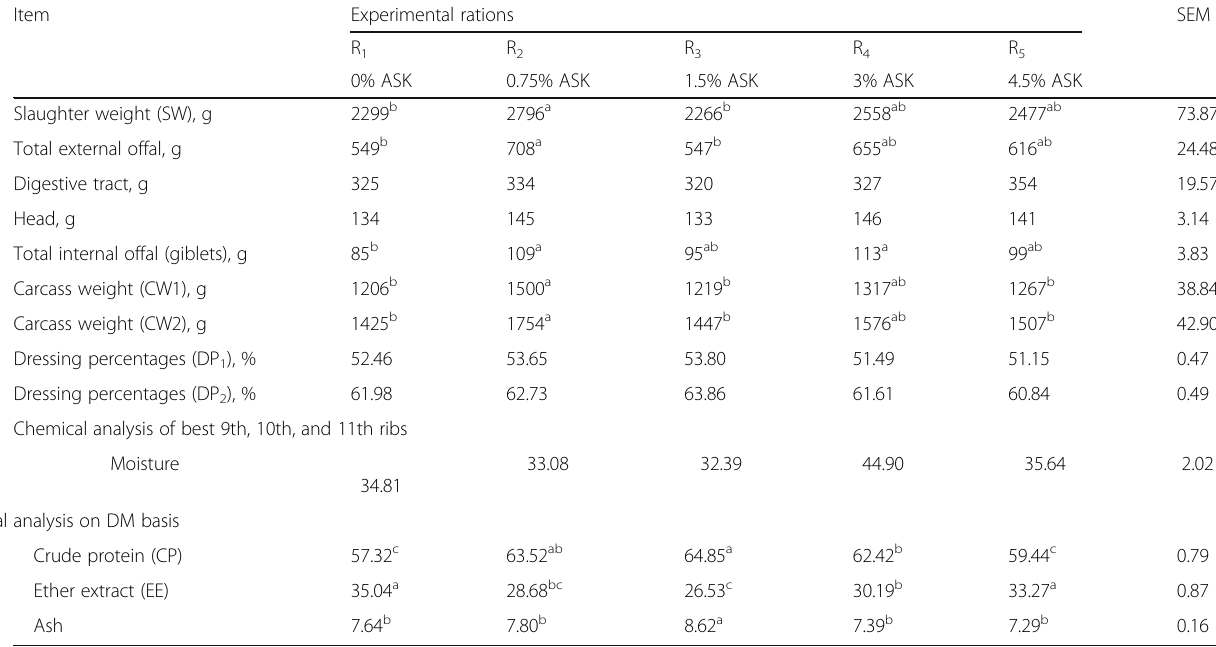
Table 4 Carcass characteristics of the experimental